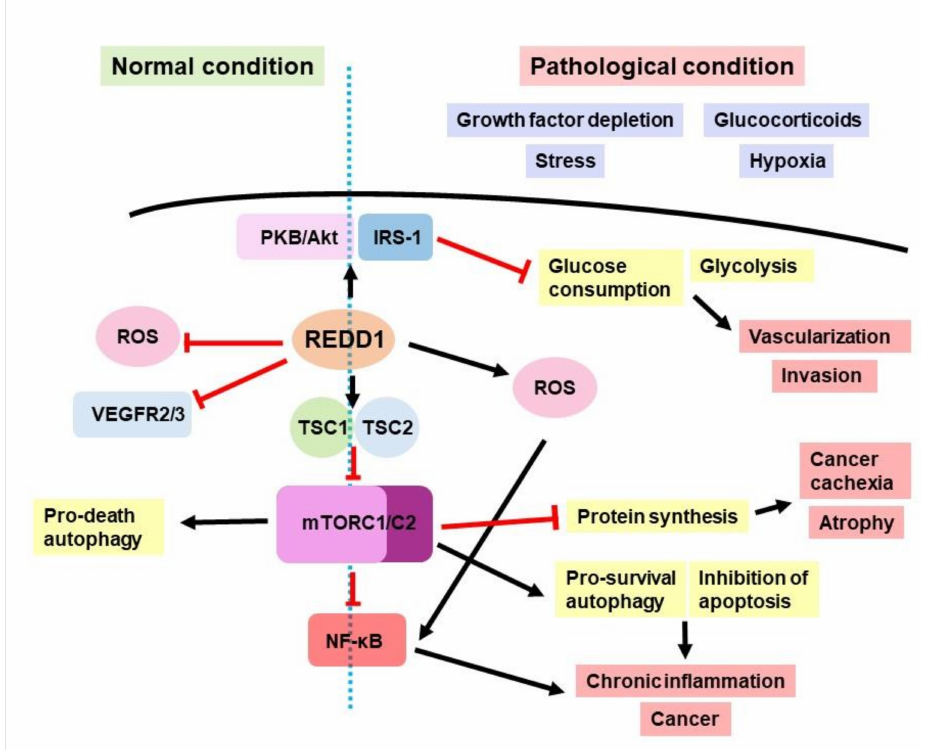
Figure 1. REDD1 role in normal and pathological conditions. REDD1 is mostly localized in cytosol and mitochondria and is involved in glucose, lipid, and protein metabolism [11,12]. Indeed, it was shown that REDD1 played an impor- tant role in energy homeostasis maintenance, down-regulating the energy expenditure in fat depots, muscles, and other metabolic tissues [13]. REDD1 was up-regulated in murine models of obesity and in obese patients [14,15]. Consistently, the knockout of REDD1 in mice on a high-fat diet promoted resistance to obesity development [14]. Moreover, REDD1 KO mice were characterized by reductions in body mass, total fat, size of gonadal white adipose tissue, and interscapular brown adipose tissue [16]. On the contrary, knockout of REDD1 in adult animals was associated with the subcutaneous and dermal white adipose tissue (dWAT) increase, as well as with the increase in the number and size of mature dermal adipocytes [16]. This finding correlated with the known control of cell size by REDD1 in Drosophila and in mammalian cells